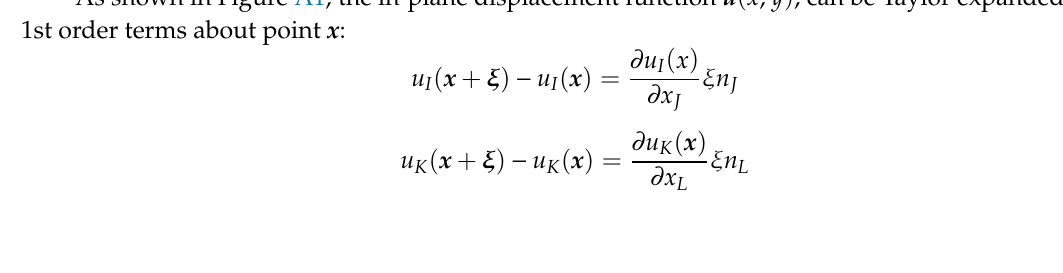
Figure A1. Peridynamic interaction between two material points.